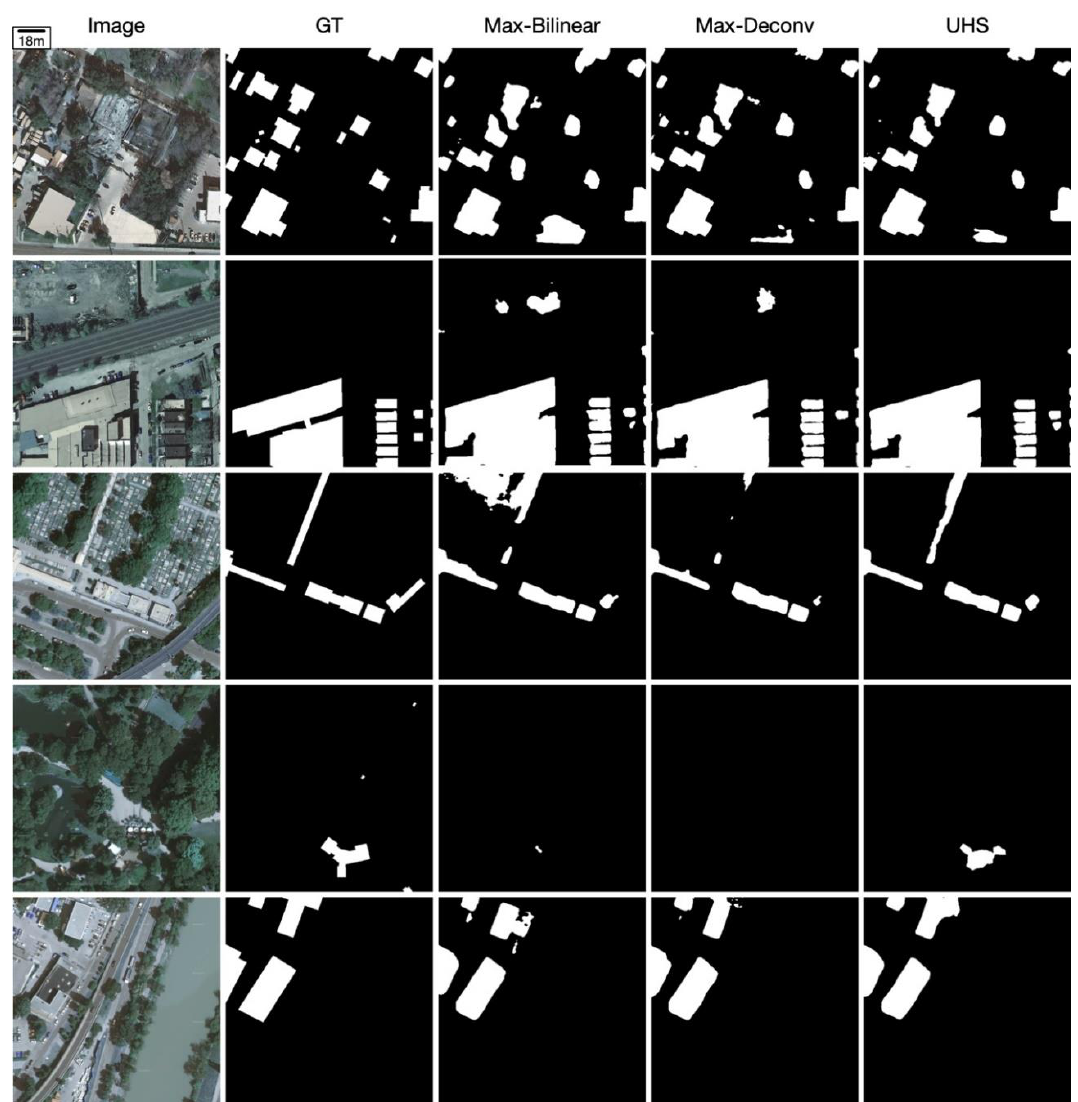
Figure 8. Examples (500×500 patches) of Web-Net with UHS, Max-Bilinear, and Max-Deconv blocks.